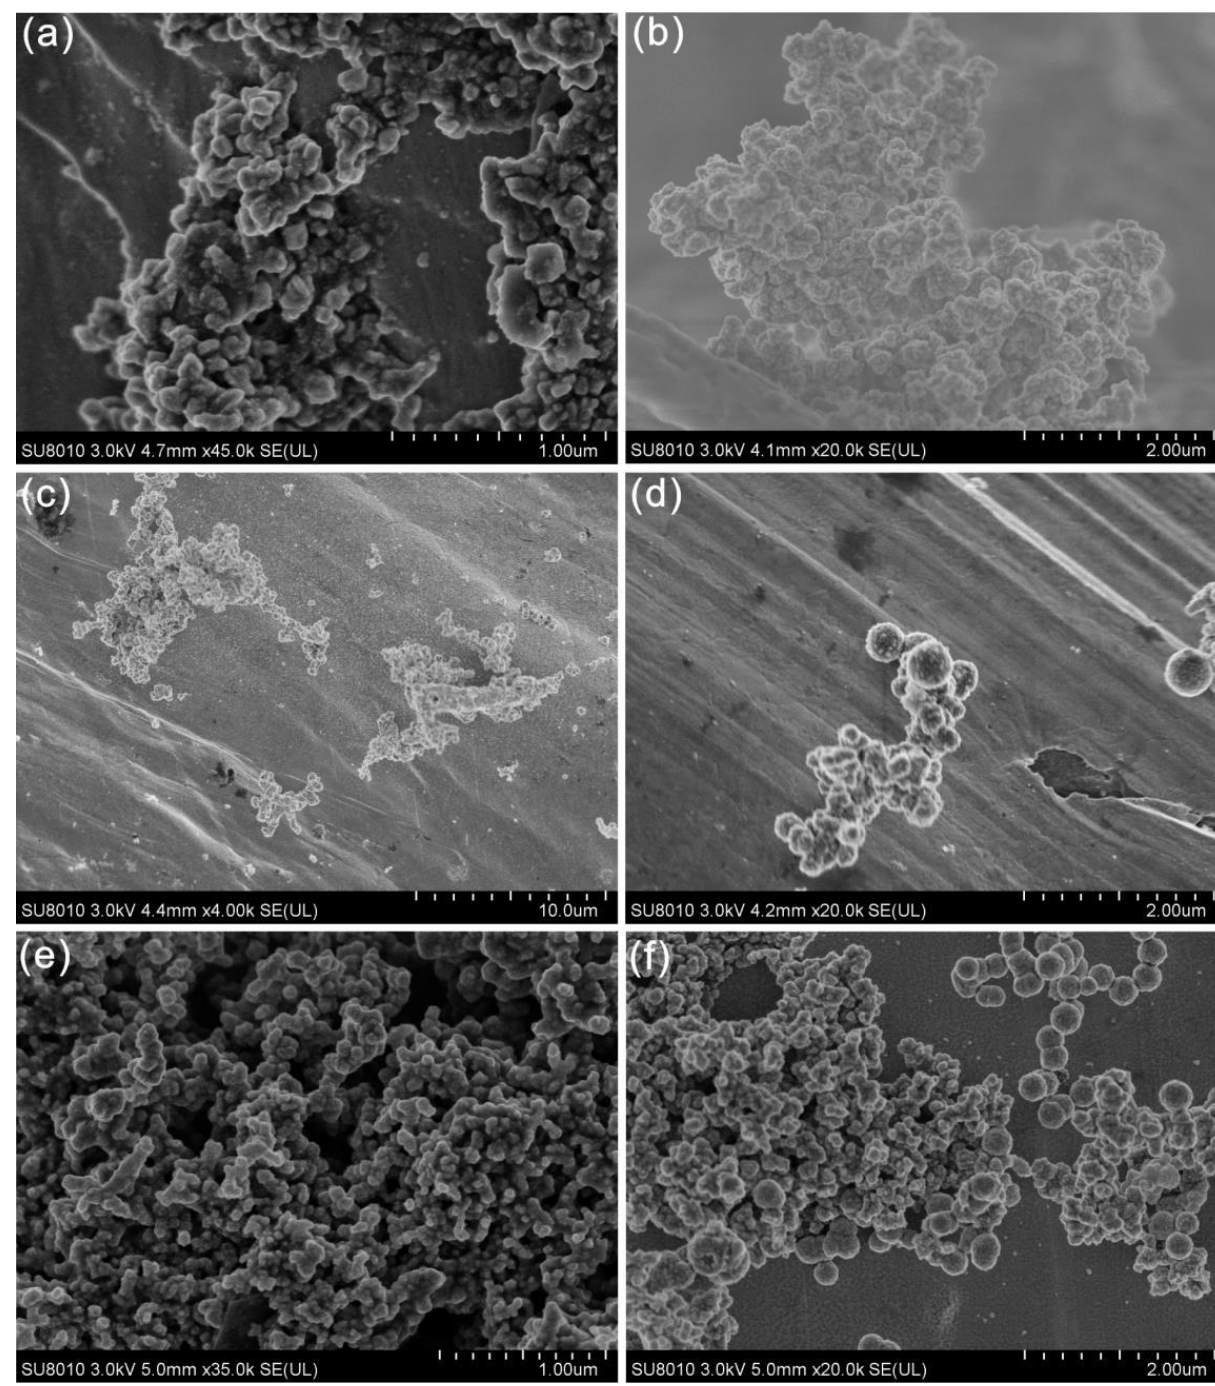
Figure 4. Representative SEM micrographs of OsO 2 nanospheres using 0.002 mol/L initial solution for: ( a ) No. 1 at 300 °C, 100 MPa, and 5 h; ( b ) No. 2 at 300 °C, 100 MPa, and 12 h; ( c ) No. 3 at 300 °C, 100 MPa, and 24 h; ( d ) No. 4 at 300 °C, 100 MPa, and 36 h; ( e ) No. 5 at 250 °C, 100 MPa, and 24 h; and ( f ) No. 6 at 450 °C, 100 MPa, and 24 h.